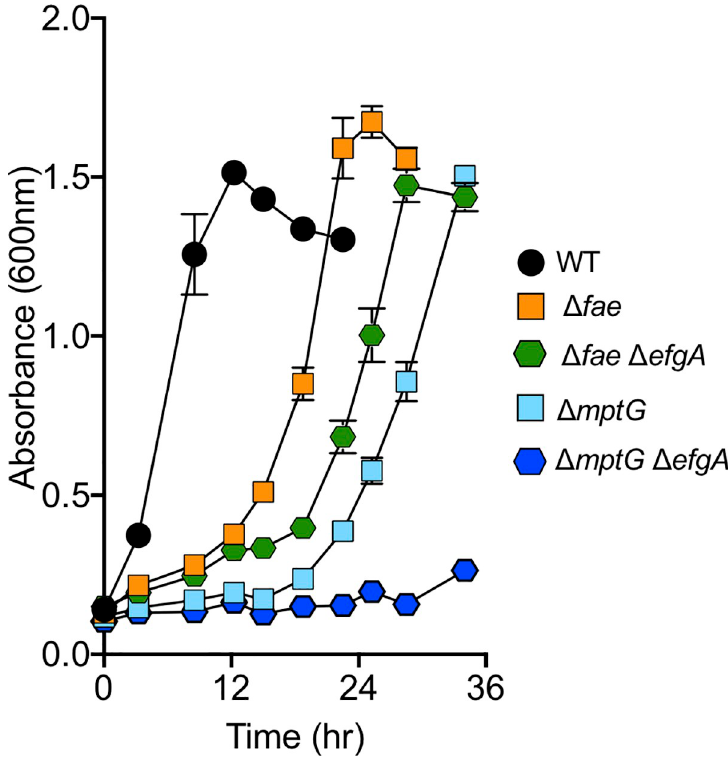
Fig 9. EfgA provides protection from internal formaldehyde in methanol sensitive mutants. Wild-type and mutant strains were grown to early exponential phase in liquid MP medium (succinate) at which point 1 mM methanol was introduced into the medium (t = 0 h). Strains represented are wild-type (black circles), Δ fae (CM3753, orange squares), Δ mptG (CM4765, light blue squares), Δ efgA Δ fae (CM3421-5, green hexagons), and Δ efgA Δ mptG mutants (CM3440- 13, blue hexagons). Error bars represent the standard error of the mean for three biological replicates. For evidence that growth of all strains on succinate (without methanol treatment) is comparable, see S18 Fig. The original data shown in this and all other figures are available in Supporting information file S1